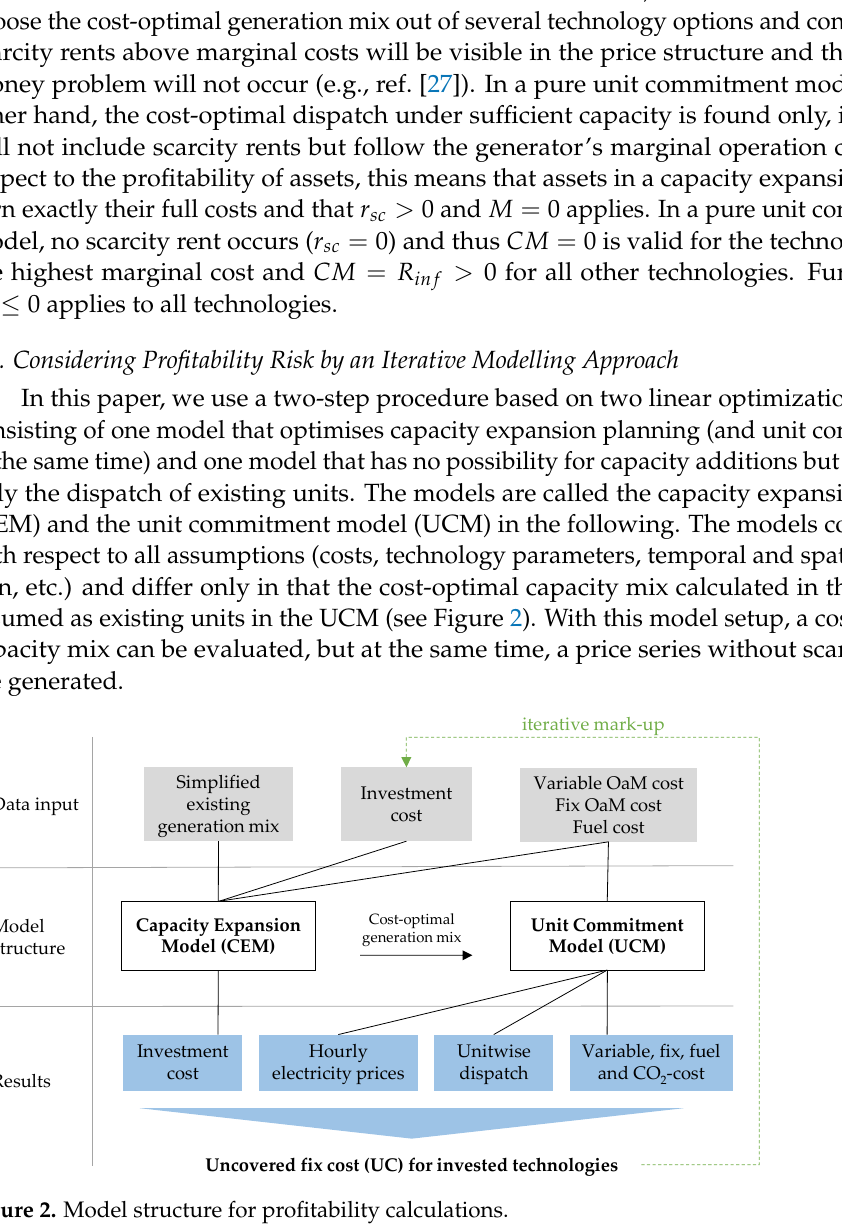
Figure 2. Model structure for profitability calculations.